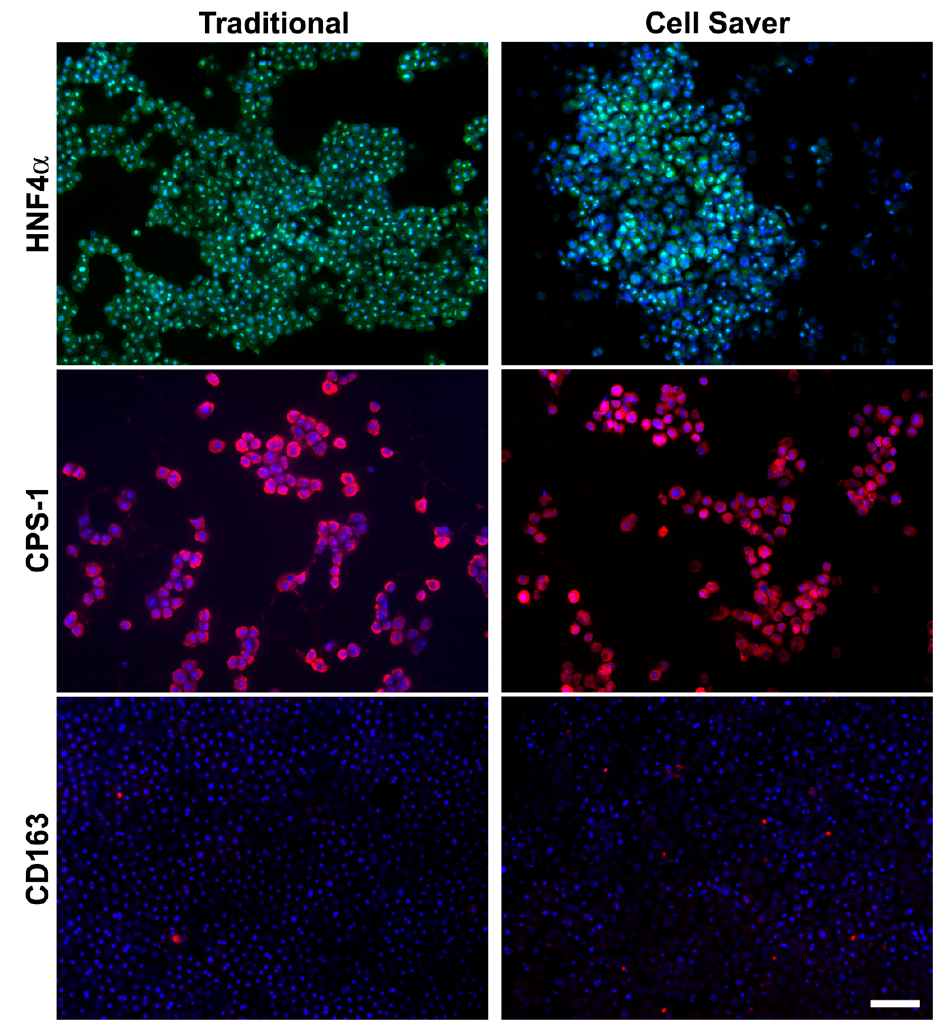
Figure 3. Phenotypic characterization of released cellular products immediately after isolation of rat livers. Majority (>85%) liver cells were mature and functional hepatocytes (positive for hepato- cyte nuclear factor 4 alpha (HNF4 α ) and carbamoyl-phosphate synthase 1 (CPS-1). Few CD163 + macrophages (red dots) were seen among isolated cells by either the traditional method and Cell Saver ® strategy. Scale bar: 100 μ m.